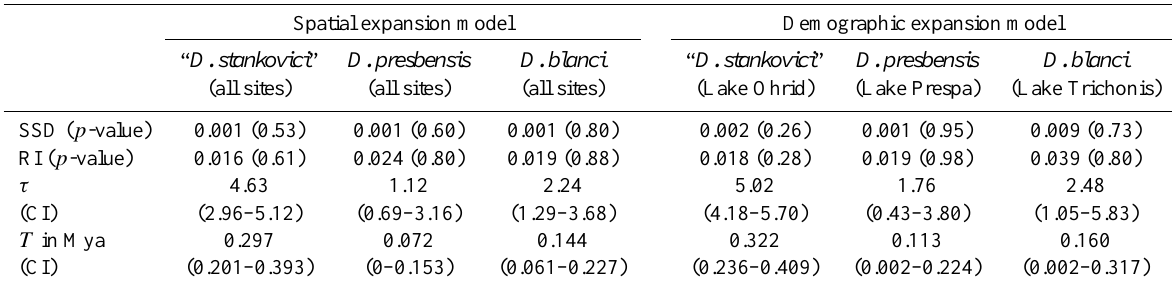
Table 5. Estimated parameters of spatial and demographic expansion models in native Dreissena spp. based on mismatch analyses. For details on the estimation of time since expansion and its confidence intervals see the Method section. SSD: sum of squared deviations from the respective model; p : significance of the respective parameter; RI: raggedness index; τ : population parameter Tau; CI: 95% confidence interval; T : time since population